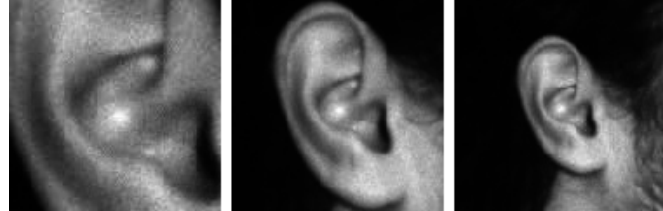
Figure 3. The three scales that are used for every data point in the training